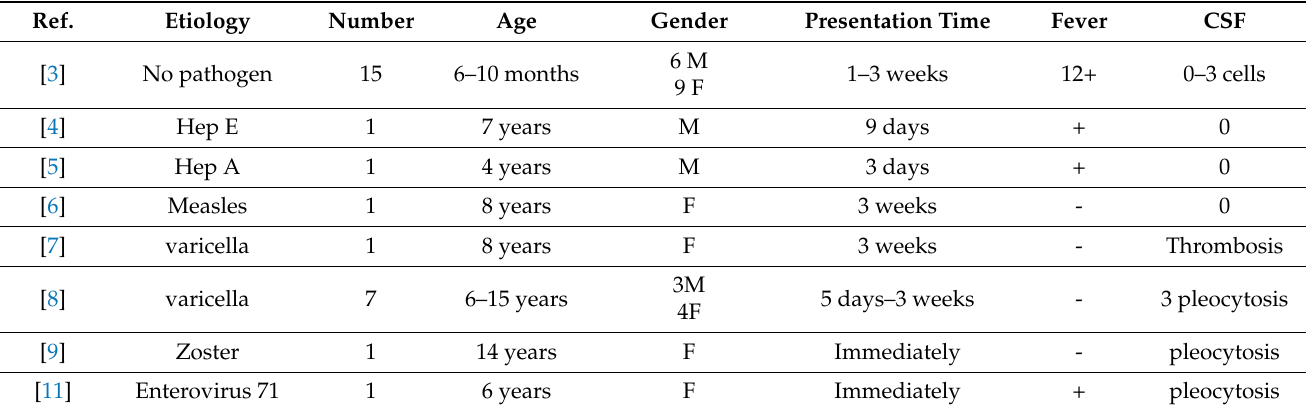
Table 3. Literature review of viral illness associated with PTC